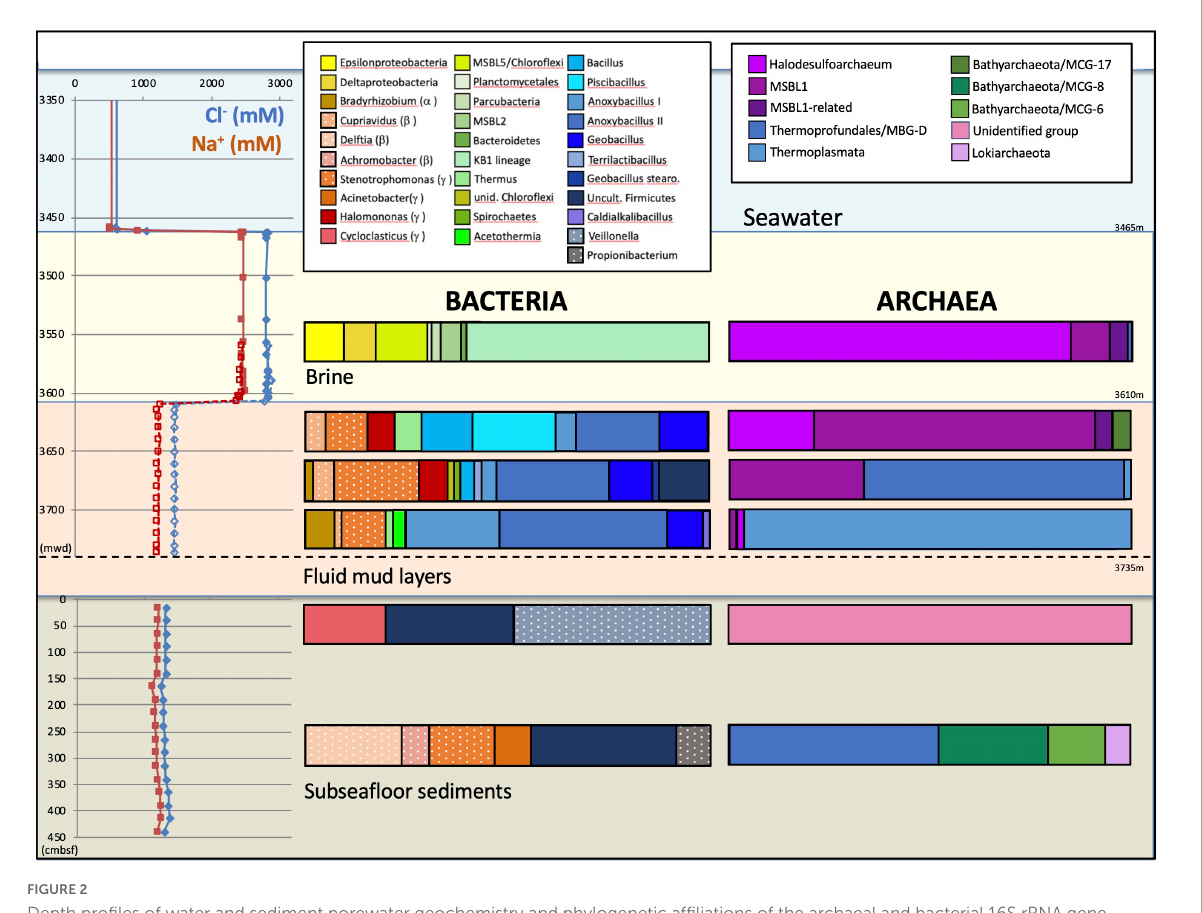
FIGURE2 Depth profiles of water and sediment porewater geochemistry and phylogenetic affiliations of the archaeal and bacterial 16S rRNA gene sequences for the three Urania Basin habitats: subseafloor sediments, mud fluid layers and brine lake. For the subseafloor sediments, depth is given in cm below the top of the gravity core. Depth is given as CTD depth for the brine fluid, and as cable length for the fluid mud layer. Sodium and chloride concentration profiles are derived from Aiello et al. (2020). Presumable contaminants are shown with a white dot